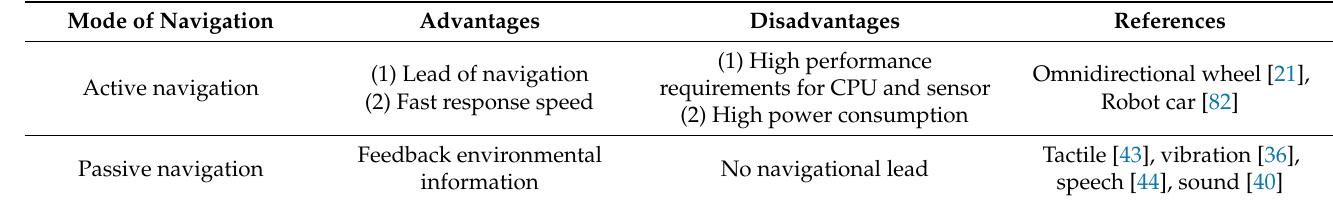
Table 4. Navigation modes of smart